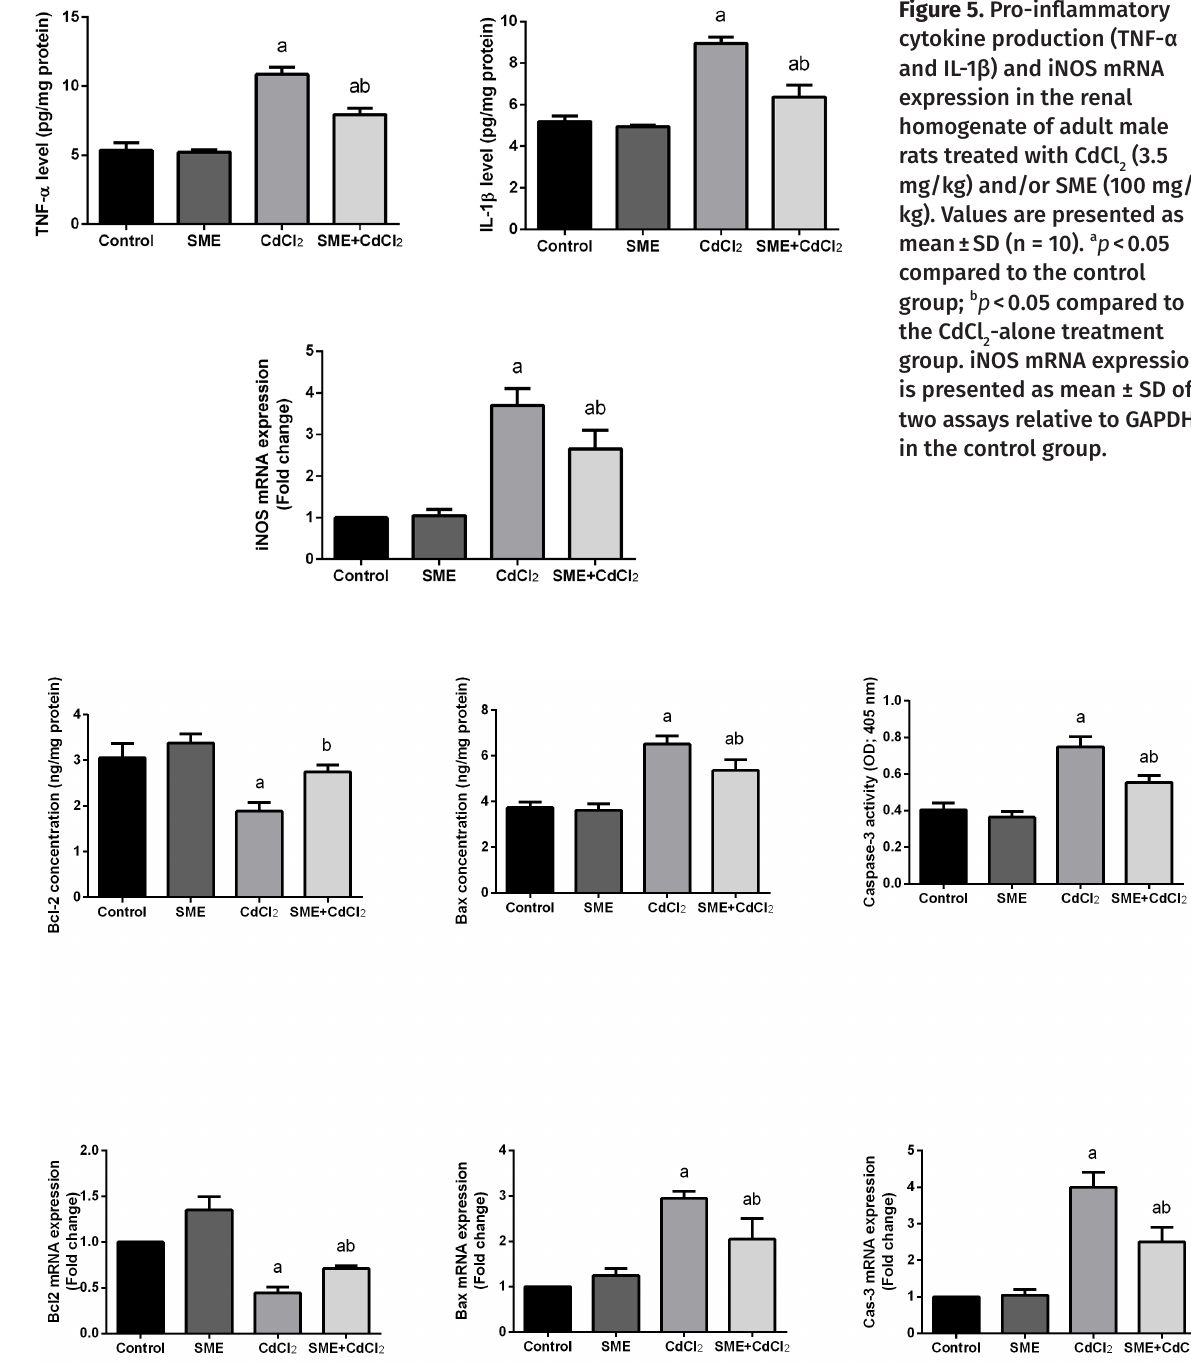
Figure 6. The apoptotic markers (Bcl-2, Bax, and caspase-3) and Bcl2 , Bax , and Cas-3 mRNA expression in the renal homogenates. Values are presented as mean ± SD (n = 10). a p < 0.05 compared to the control group; b p < 0.05 compared to the CdCl -alone treatment group. Cas-3, Bax and Bcl2 mRNA levels are presented as mean ± SD of two 2 assays relative to GAPDH in the control